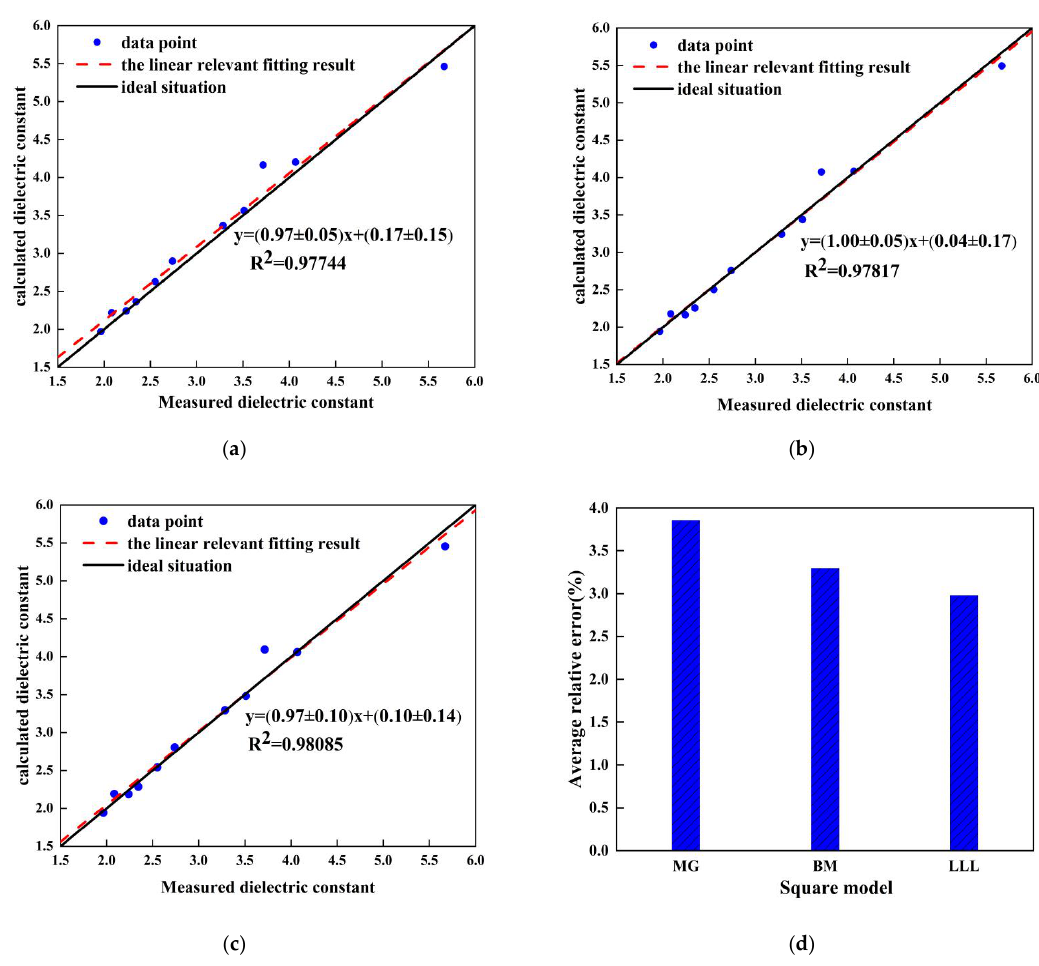
Figure 12. Comparisons of measured and calculated dielectric constants: ( a ) Measured dielectric constant and calculated values of MG model; ( b ) measured dielectric constant and calculated values of BM model; ( c ) measured dielectric constant and calculated values of the LLL model; ( d ) error analysis of each model.